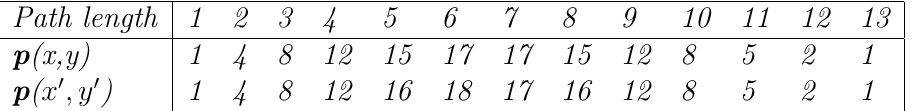
Table 7 : Path vectors for edges 𝑥𝑦 and 𝑥 ′ 𝑦 ′ in trees 𝑇 ′′ and 𝑇 ′′′ respectively in Figure 4. One can see that p ( 𝑥 ) = p ( 𝑥 ′ ) and p ( 𝑦 ) = p ( 𝑦 ′ ) but 𝑝